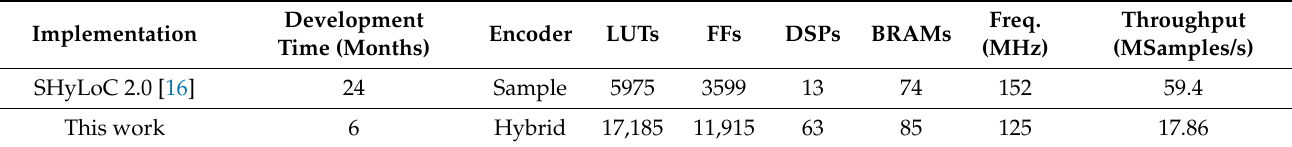
Table 4. Comparison between CCSDS-123 VHDL and HLS